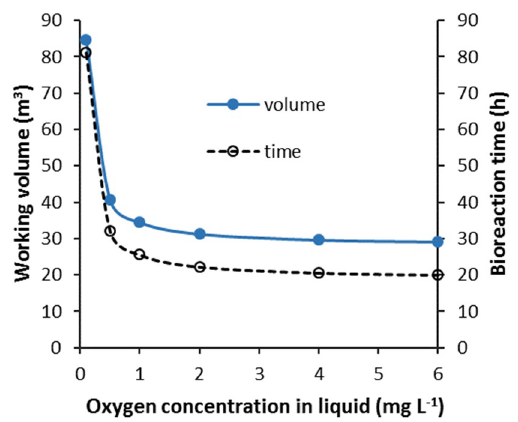
Figure 4. Effect of oxygen concentration on bioreaction time and bioreactor working volume for batch